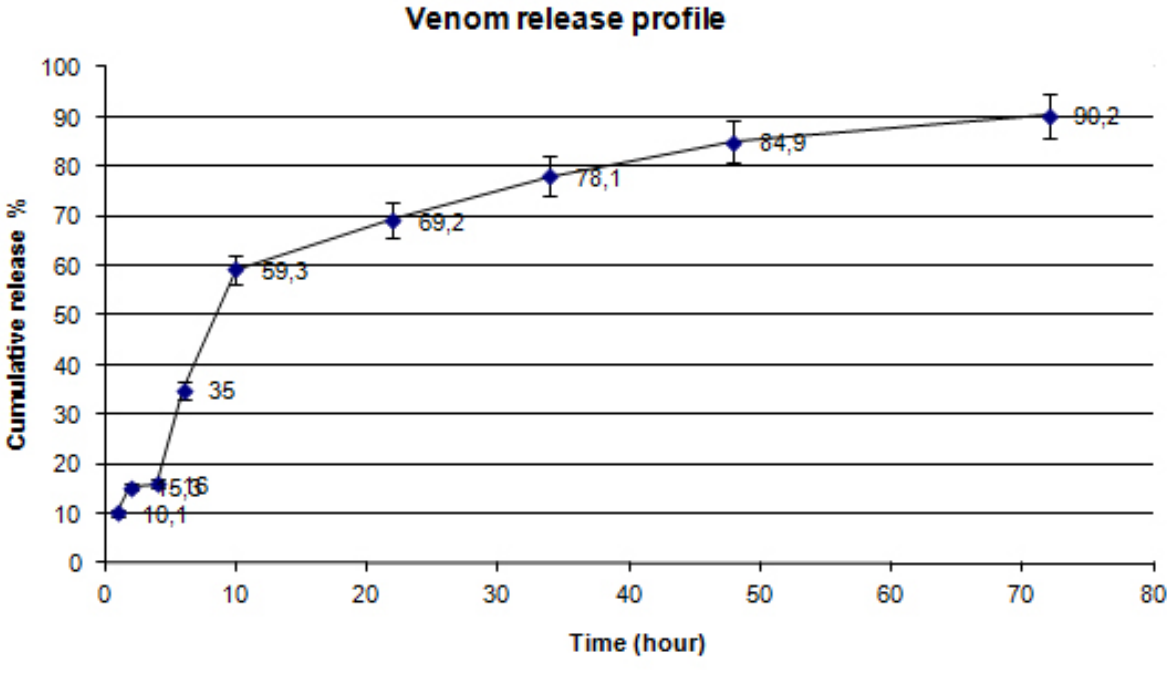
Figure 5. M. eupeus venom release profile from venom-loaded chitosan nanoparticles (chitosan 2 mg/mL, TPP 1 mg/mL, initial M. eupeus venom 500 µg/mL, medium pH: